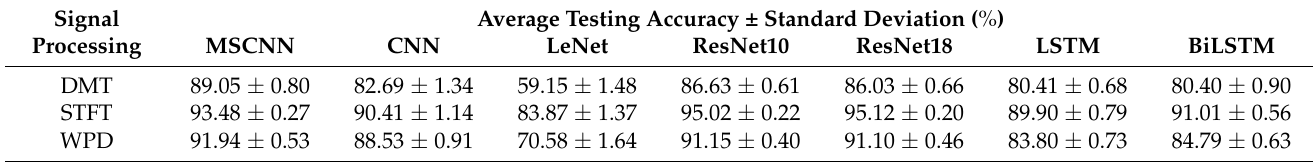
Table 8. Experimental results of the bearing